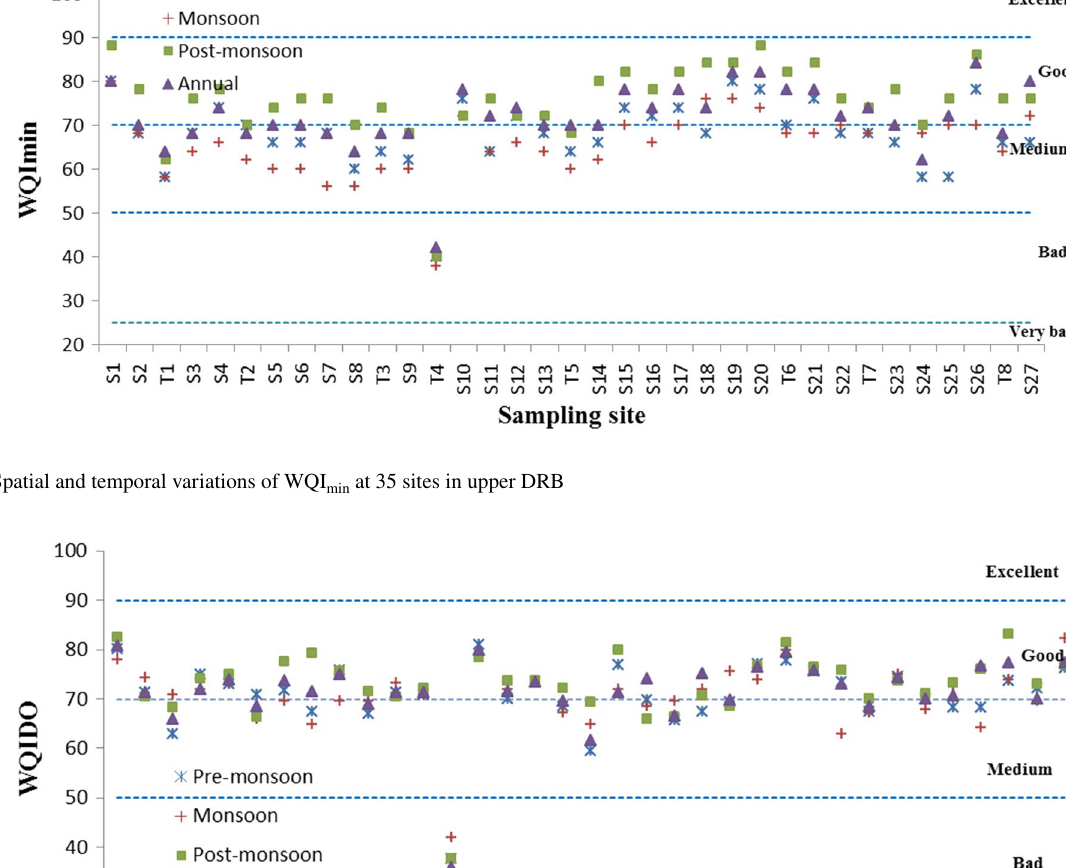
Fig. 7 Spatial and temporal variations of WQI